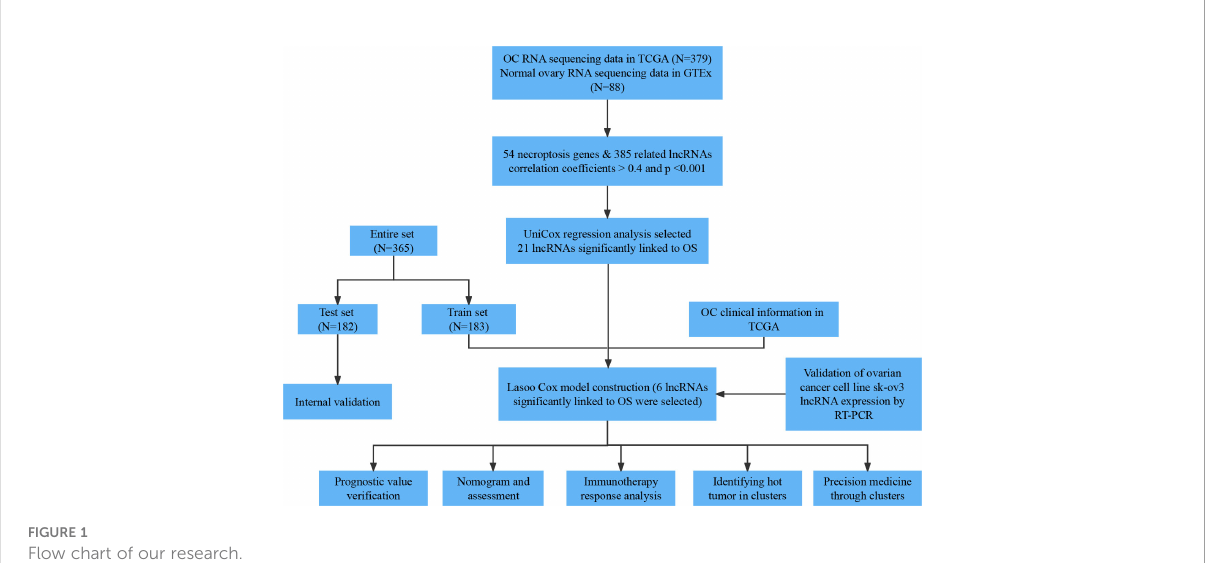
FIGURE 1 Flow chart of our